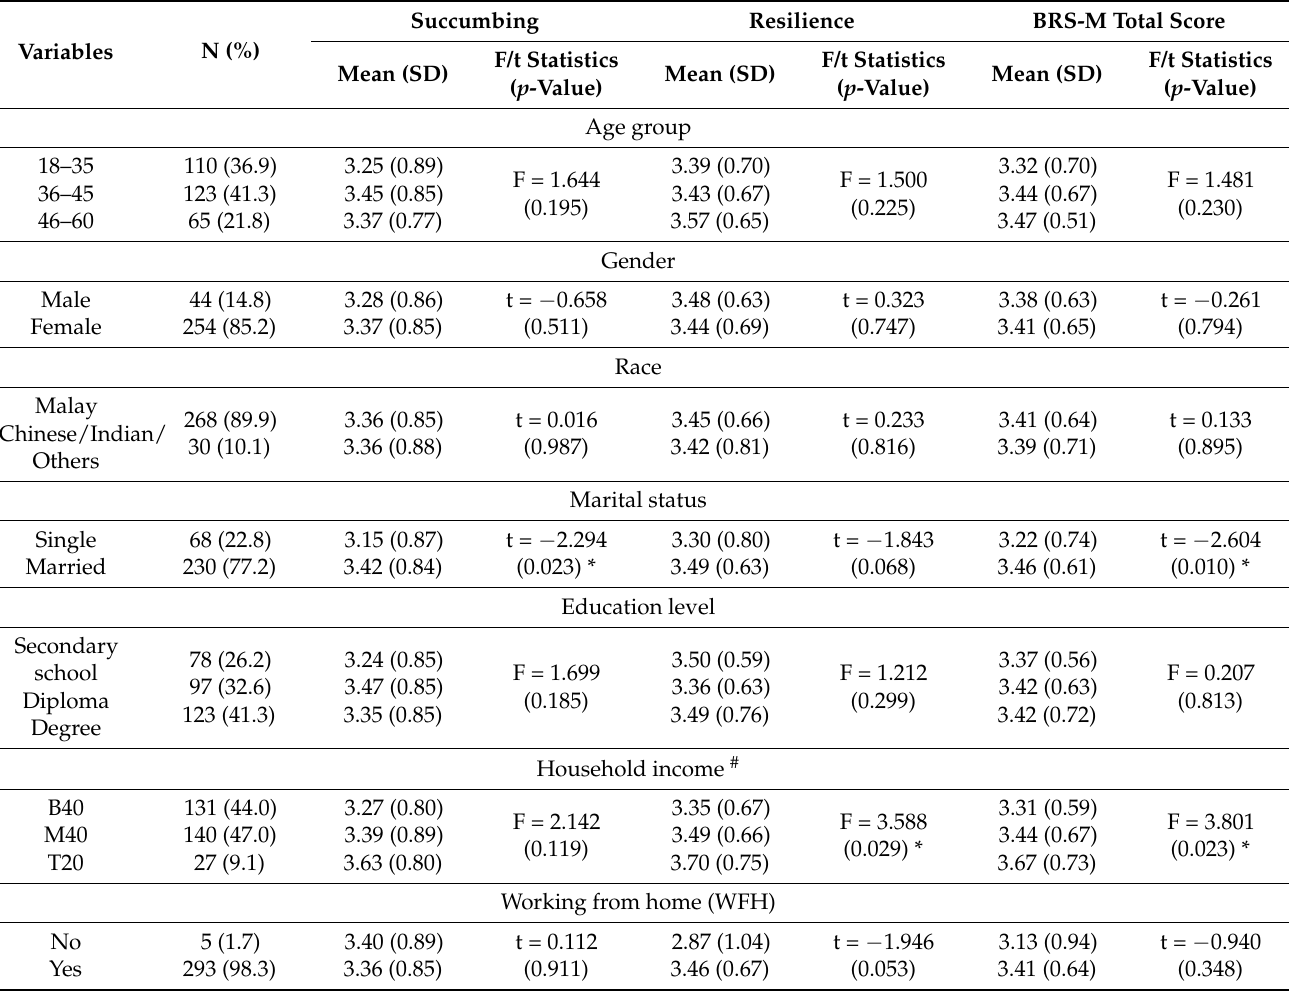
Table 4. Univariable analysis between BRS-M subfactor scores and BRS-M total score with sociode- mographic factors (n = 298).